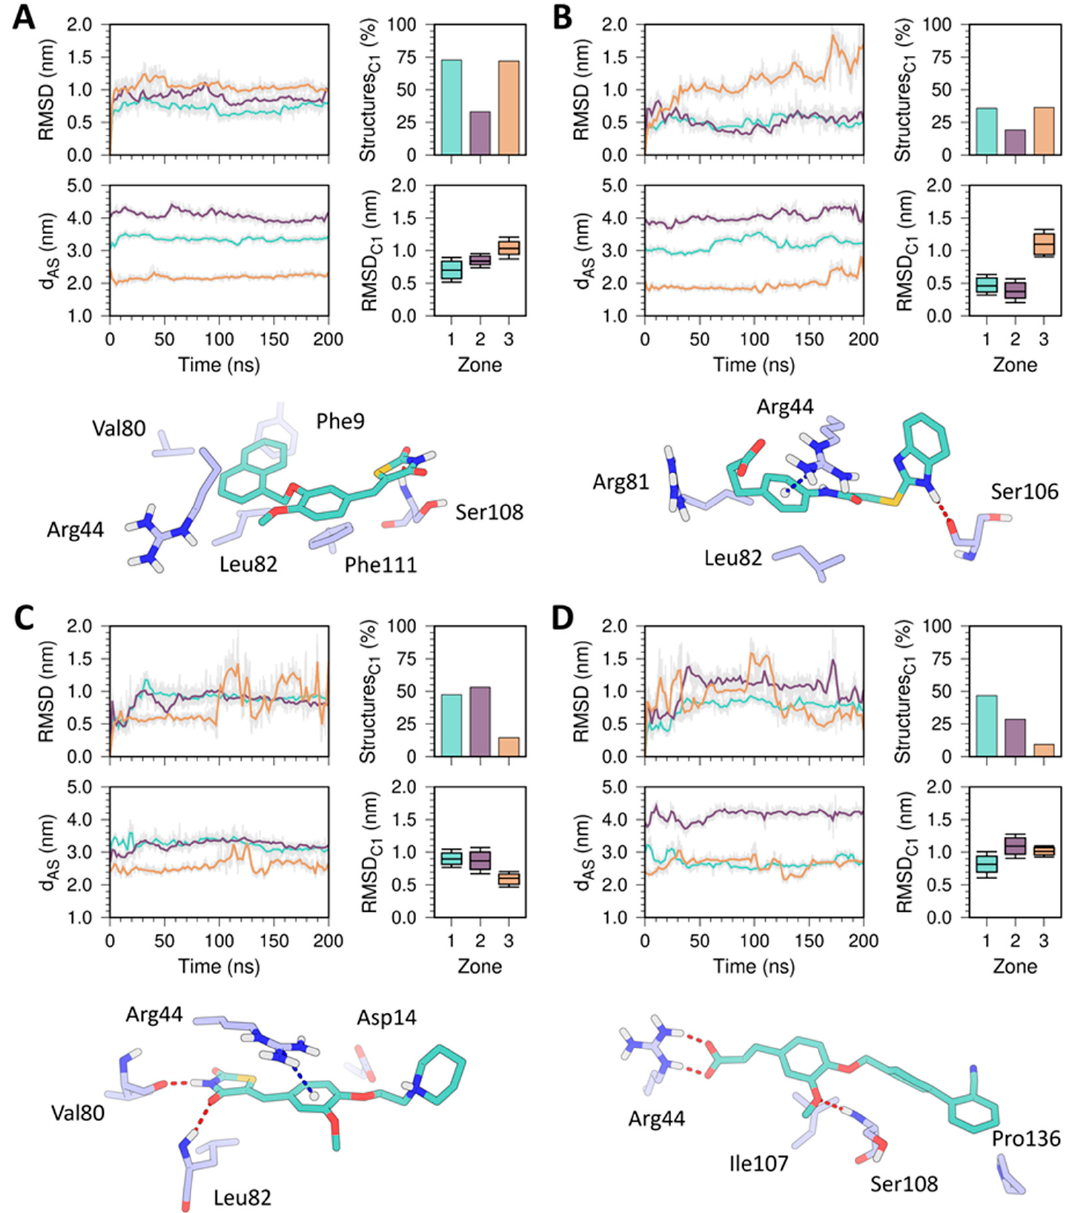
Figure 9. MD simulation analysis of compounds ( A ) YGC-1 ; ( B ) MGD-1 ; ( C ) TDA-1 ; and ( D ) JMM-3 in Zones 1 (cyan), 2 (purple), and 3 (orange) on the HpG6PD model. The plots in the figure show the RMSD over time (200 ns) of each compound after the least-square fit to the HpG6PD backbone (top left), the distance between the geometry centers of the ligand and HpG6PD active site (dAS, bottom left), and the percentage of structures (top right) and RMSD distribution (bottom right) of the most populated clusters (C1). The tridimensional structures beneath the plots depict the compound interaction of the C1 cluster in zone 1 on the HpG6PD model. The H-bond and cation– π interactions are shown in red and blue dashed lines, respectively.